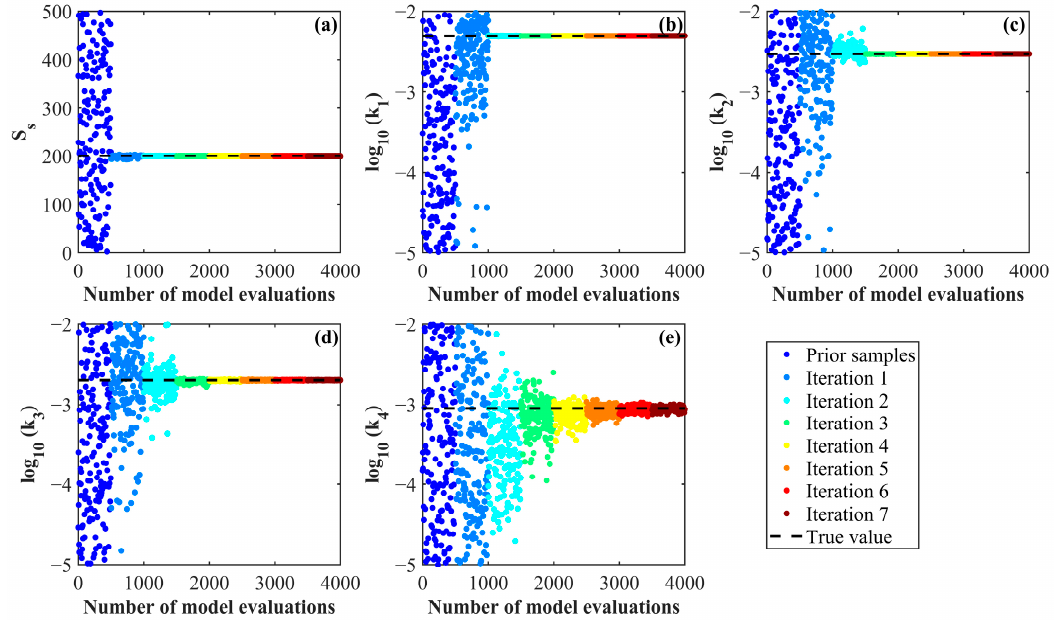
Figure 3. Trace plots of unknown model parameters estimated by the ILUES algorithm in Case 1. ( a ) represents the trace plot of the source strength ( S S ) . ( b – e ) represents the trace plot of the four rate constants ( k 1 , k 2 , k 3 , k 4 ) , respectively. The black dashed lines denote the reference true values of corresponding model parameters.